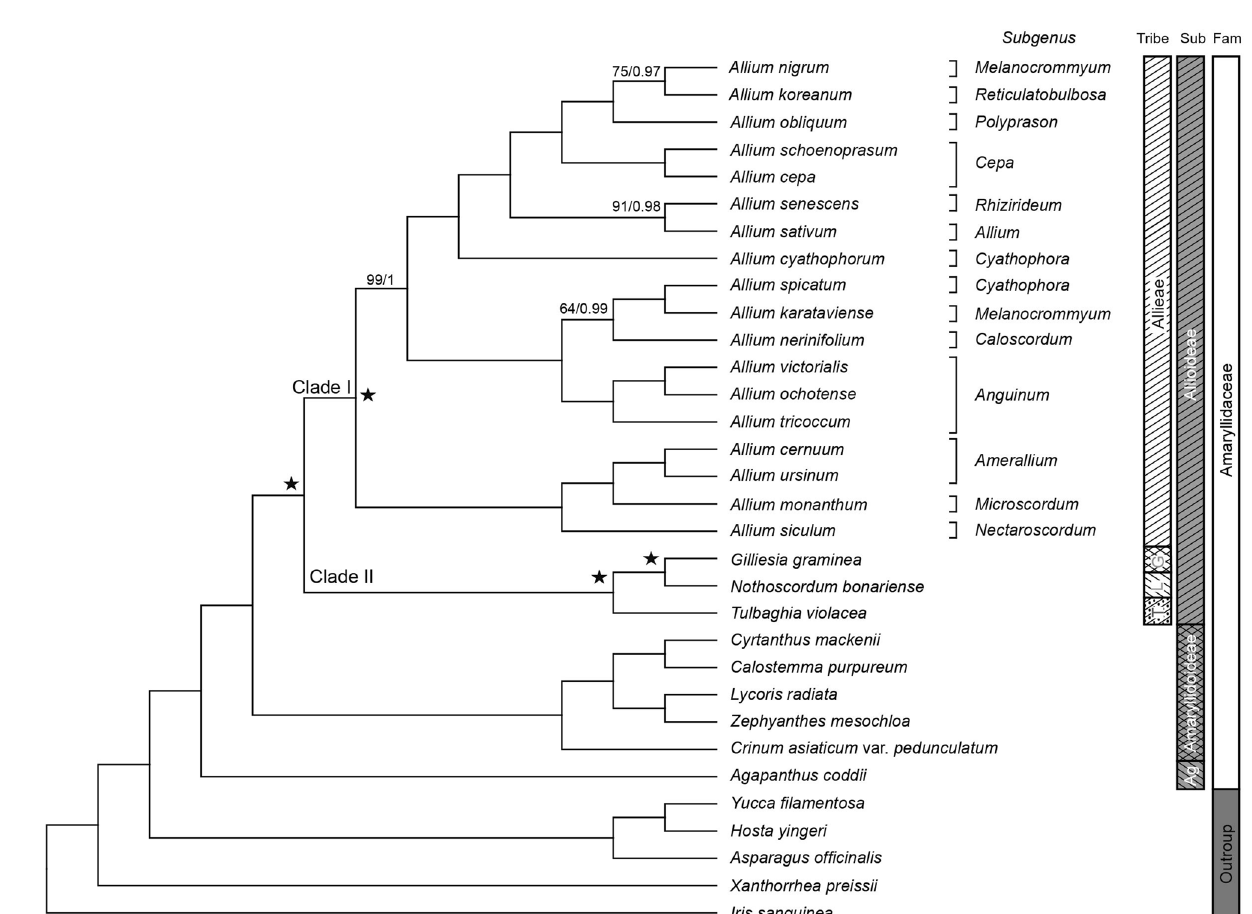
Figure 2. Maximum parsimony tree inferred from 74 protein-coding regions of 32 chloroplast genomes from Allioideae and related taxa. Numbers represent support values (bootstrap [BP]/ posterior probability [PP]). Only support values below BP = 100/PP = 1 are shown. Tri: Tribe; Sub: Subfamily; Fam: Family; T: Tulbaghieae; L: Leucocoryneae; G: Gilliesieae; Ag: Agapanthoideae. Clade I, Clade II, and black stars indicate interested points for further